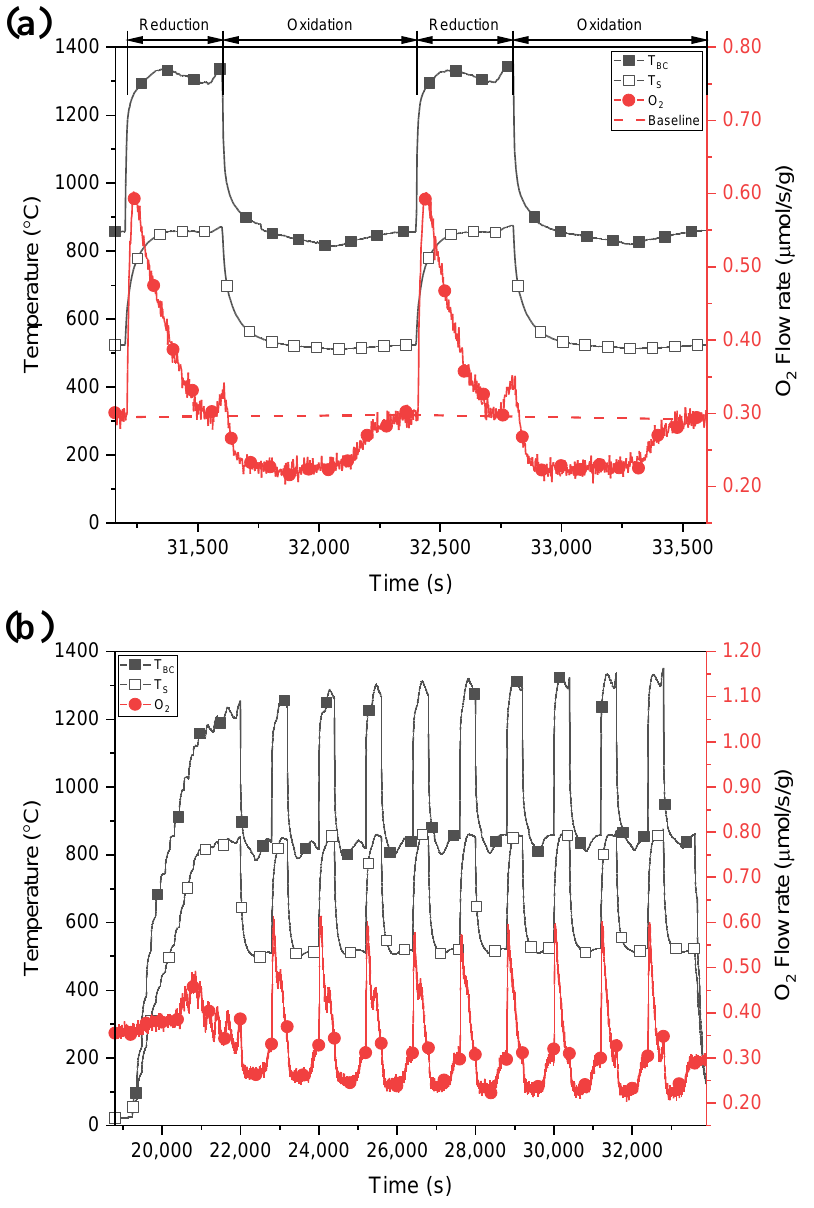
Figure 7. O 2 production and consumption during ( a ) exemplary temperature-swing cycles and ( b ) first 10 temperature-swing cycles with constant p O 2 , and corresponding temperature profiles of porous ceria. Symbols are for visual purposes only. δ red and the Δ δ for the total of 200 temperature-swing cycles are shown in Figure 8. δ red initially was 0.0075 for the first 5 cycles, but decreased to 0.0064 during the cycles 30 to 35. The decrease in the δ red continued almost linearly with cycling number, but became flatter near cycle 120 for the remainder of cycles. The average δ red between cycle 120 and 200 was 0.0044 ± 0.0004. Δ δ decreased